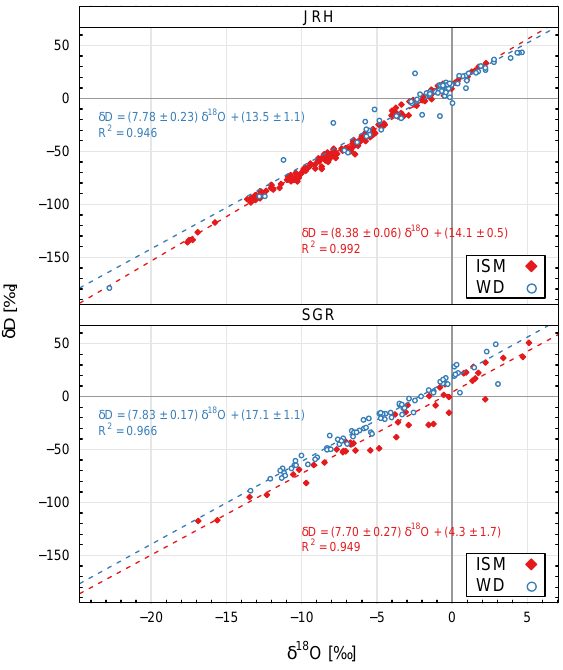
Figure 3. Seasonal variations of δ 18 O (a) and d -excess (b) of daily rainfall collected at the Jorhat (JRH) and Srinagar (SGR) sta- tions. The Indian summer monsoon (ISM) period at Srinagar (July– September) and Jorhat (May–September) is marked in blue and red shading, respectively.